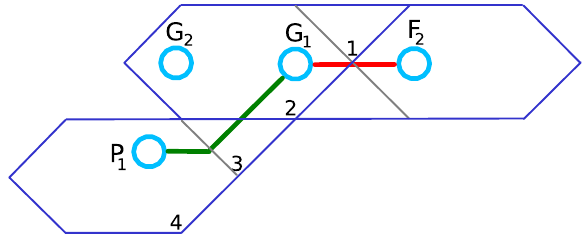
FIG. 13. Double plaquettes used in the working example of a single